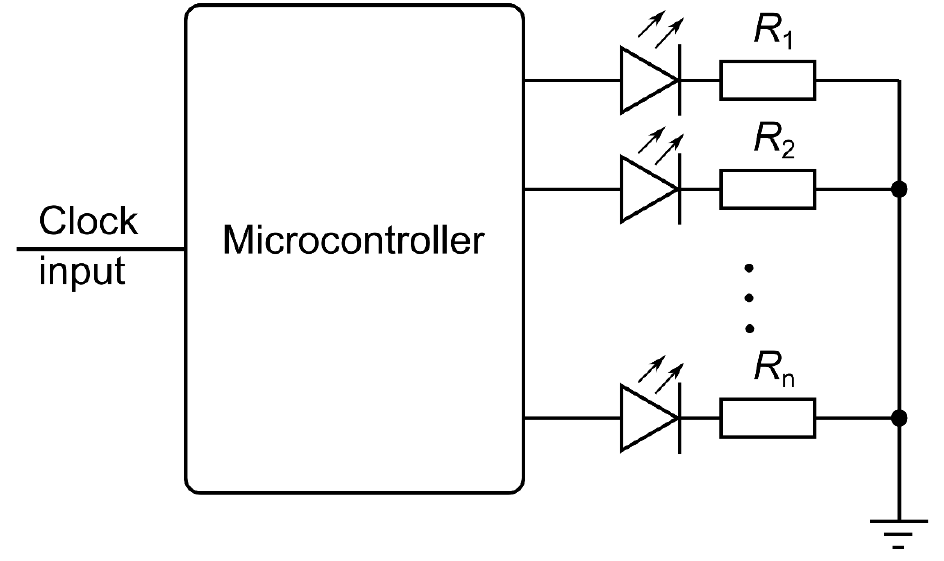
Figure 1. Block diagram of the proposed solution [20,21].